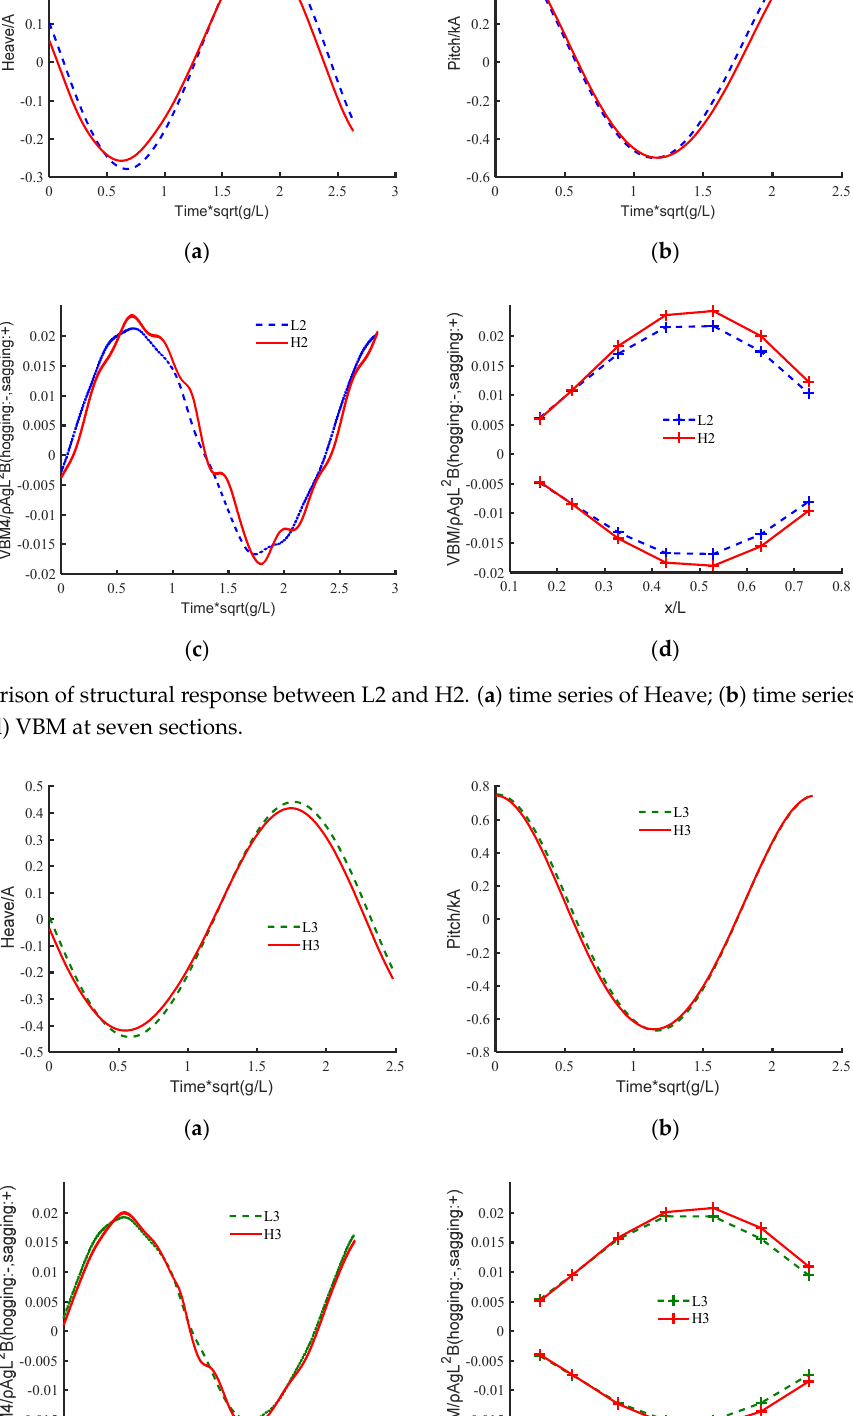
Figure 14. Comparison of structural response between L1 and H1. ( a ) time series of Heave; ( b ) time series of Pitch; ( c ) time series of VBM4; ( d ) VBM at seven sections.